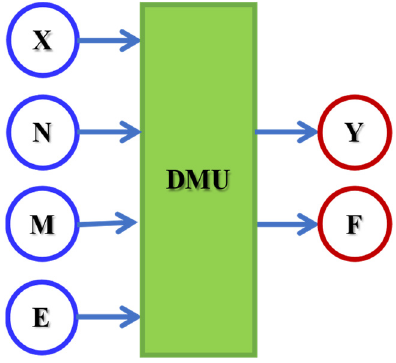
Figure 1. DEA model.